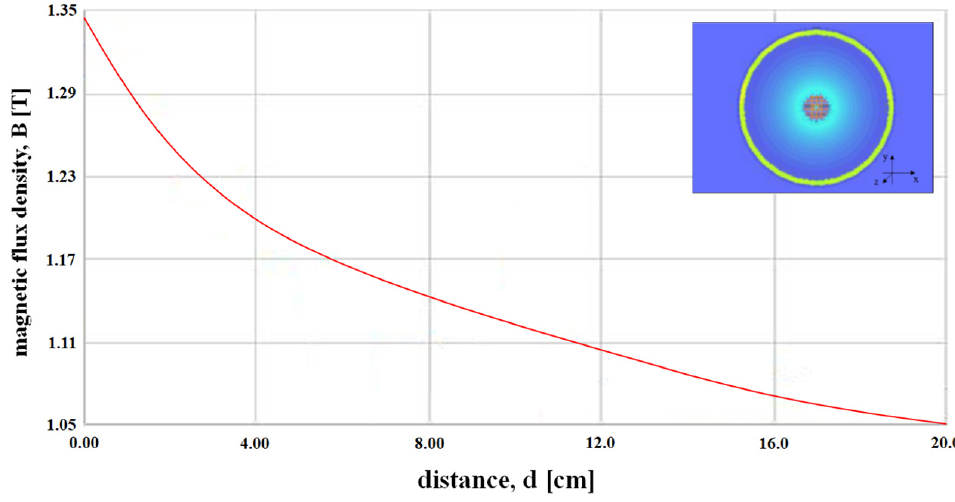
Figure 5. Simulation result of the magnetic flux density with respect to the distance from the magnet.